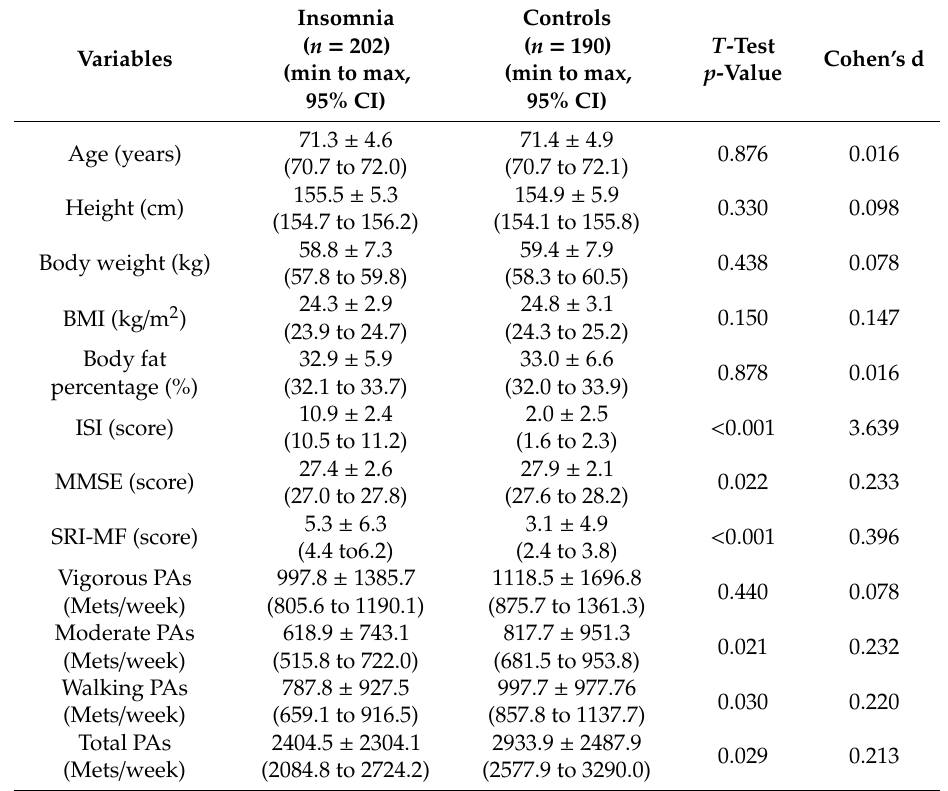
Figure 1. Recruitment process flowchart. Table 1. Demographic characteristics of the study participants.